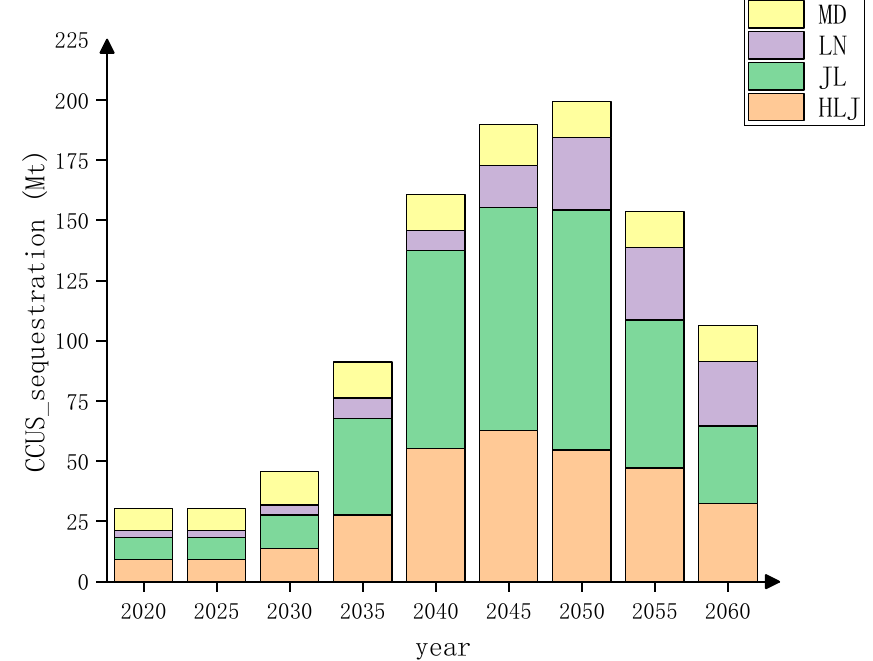
Figure 4. CCUS sequestration of Northeast Power Grid region in the BAU scenario between 2020 and 2060.